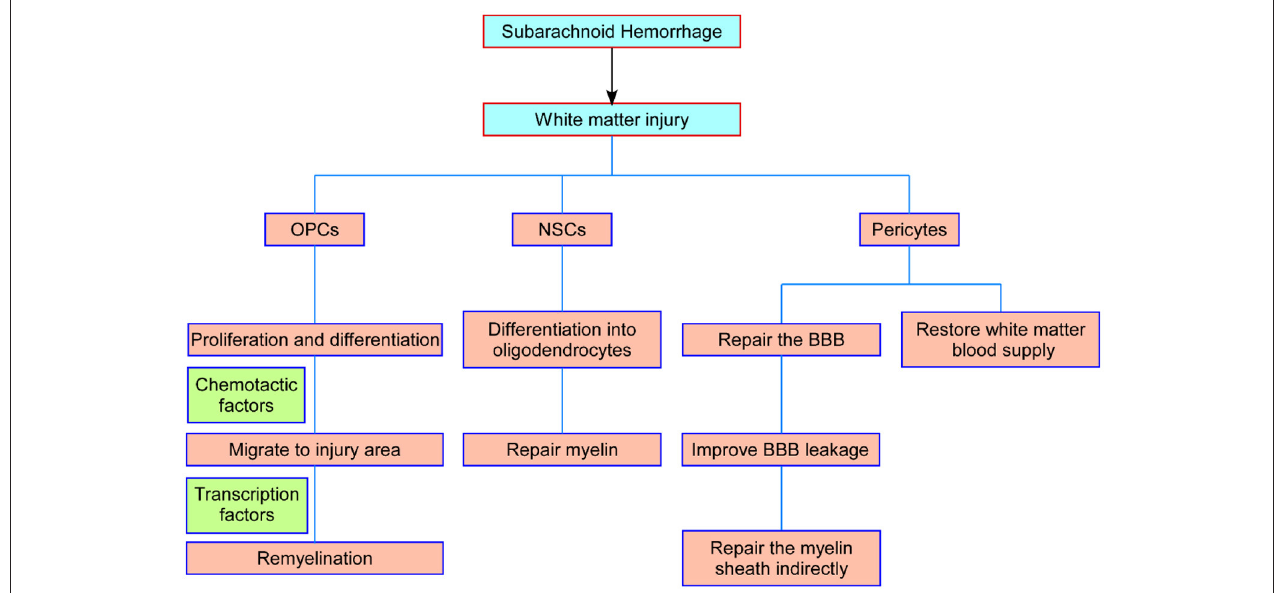
FIGURE 2 | Schematic representation of the main processes of NSCs, OPCs, and pericytes in white matter repair after SAH. OPCs proliferate and migrate to the injured foci and differentiate into oligodendrocytes to repair damaged myelin. NSCs differentiate into white matter neurons and oligodendrocytes to repair axons and myelin. Pericytes restore the blood supply to the white matter by modulating capillary constriction; moreover, pericytes enhance BBB integrity and alleviate white matter injury after SAH. NSCs, neural stem cells; OPCs, oligodendrocyte precursor cells; SAH, subarachnoid hemorrhage; BBB, blood–brain